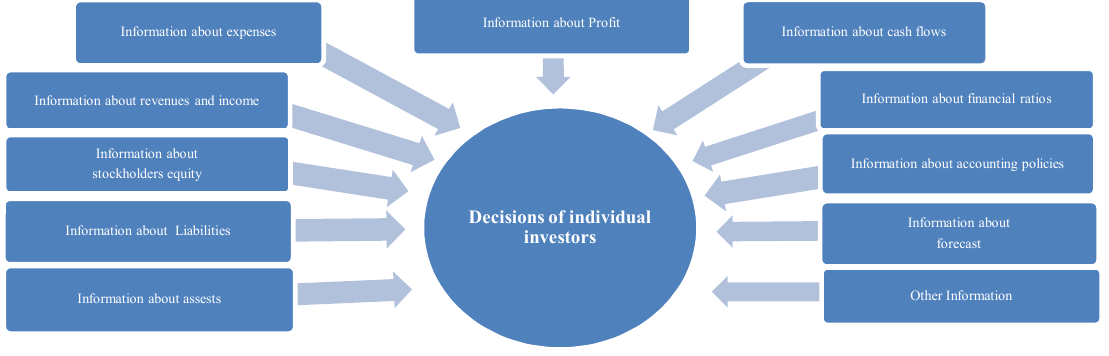
Fig. 1. The research